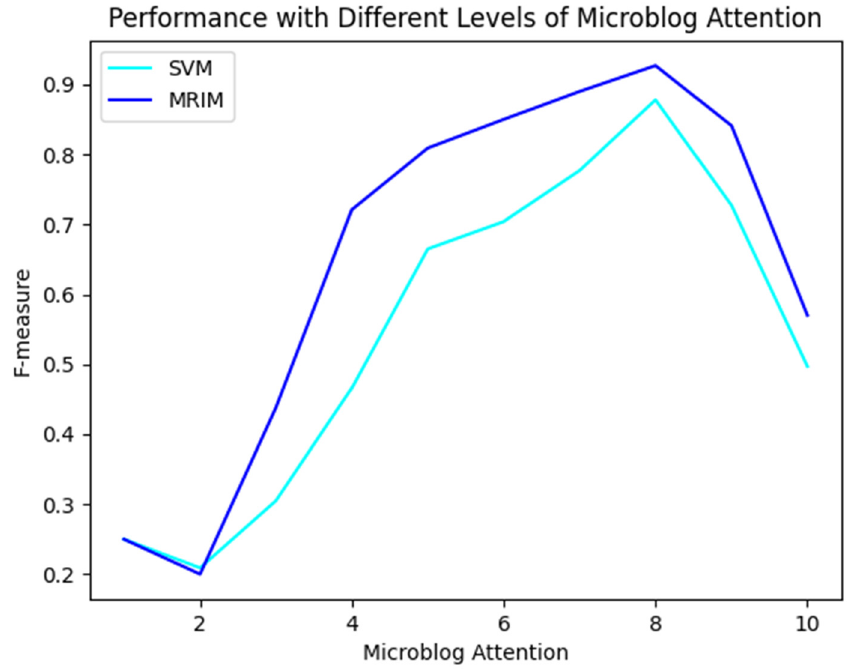
Figure 5. The performance on groups with different levels of microblog